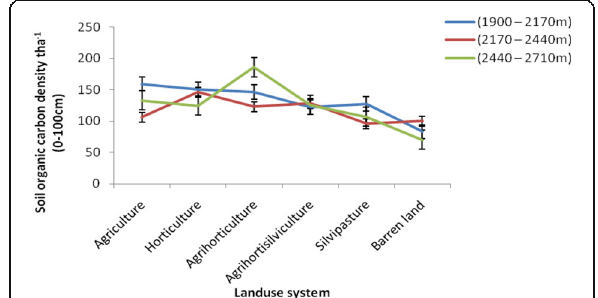
Fig. 4 Status of SOC (%) in different land use systems